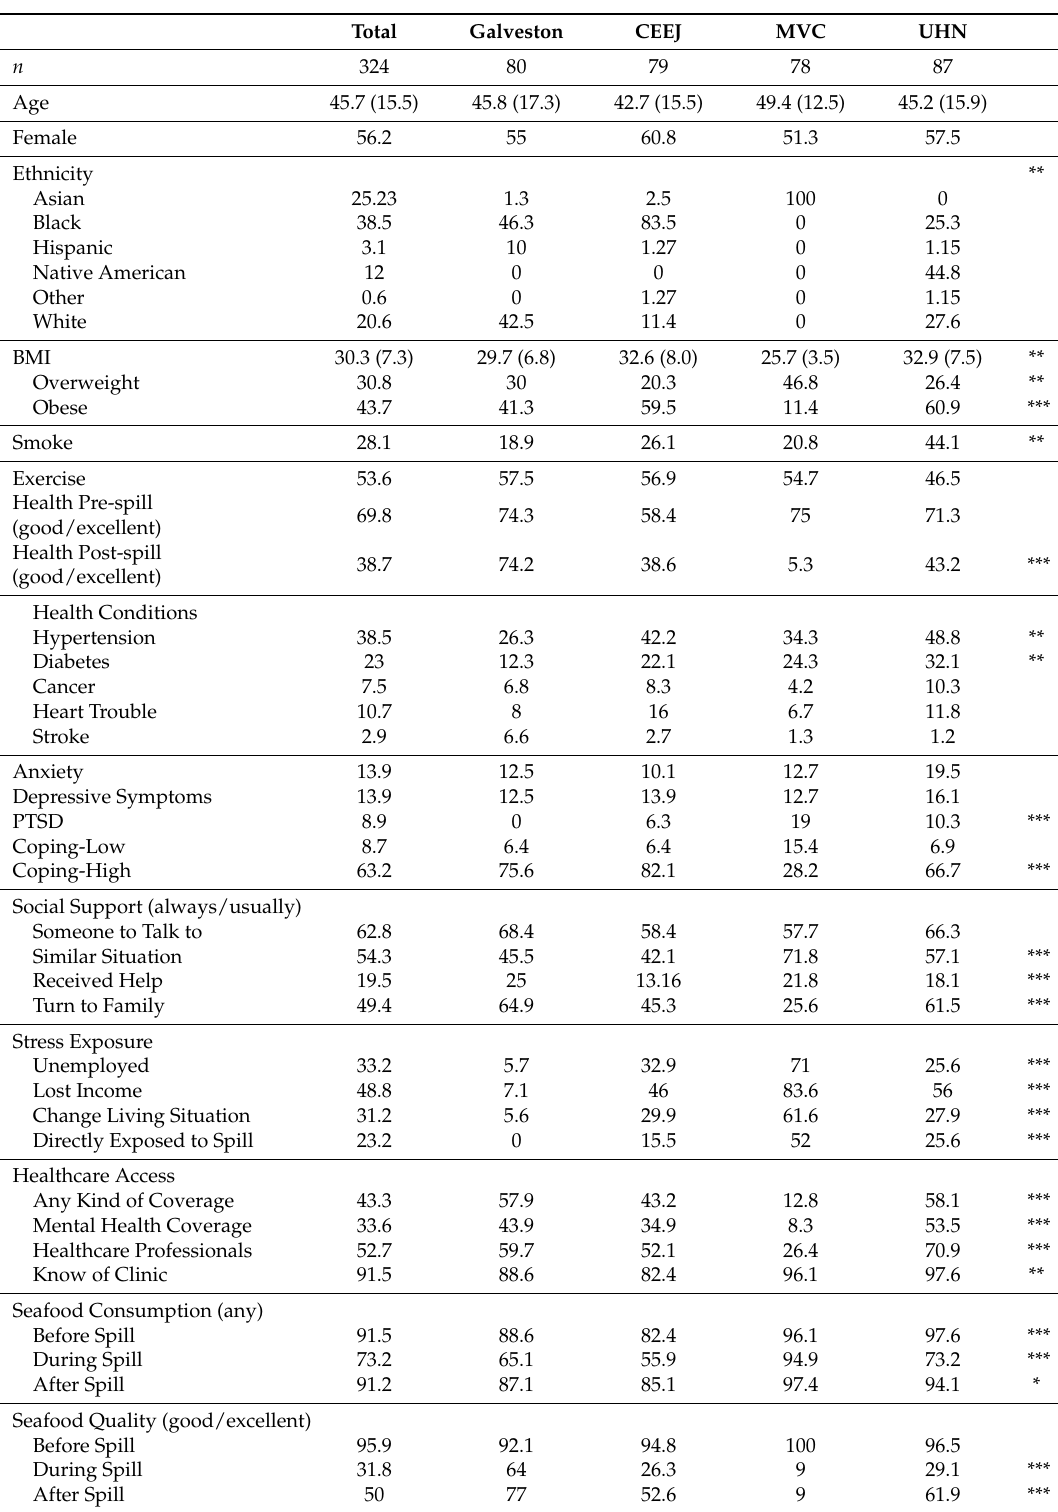
Table 1. Characteristics of Gulf Coast Health Alliance: health Risks related to the Macondo Spill (GC-HARMS) sampled adults 18 years and older by interview site-mean (standard deviation; SD) or %.